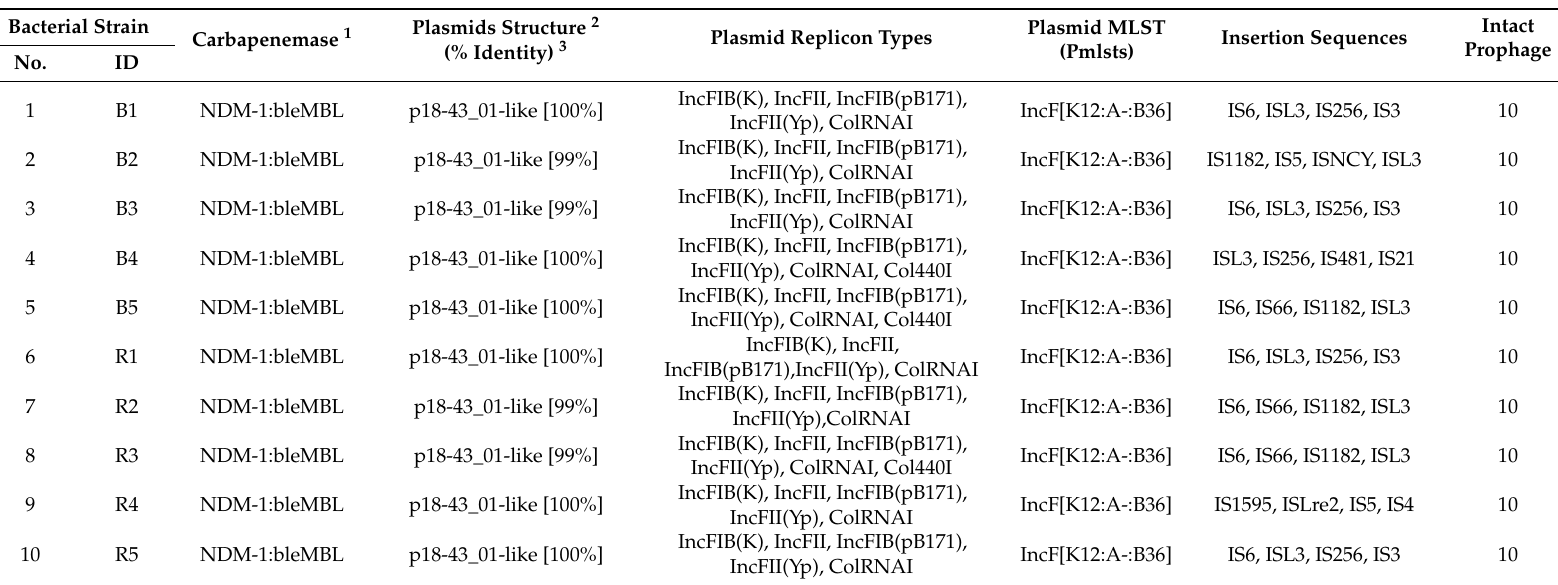
Table 3. Genetic environment of carbapenemase-encoding bla NDM-1 genetic structure borne on a plasmid with other mobile genetic elements. Bacterial Strain Carbapenemase 1